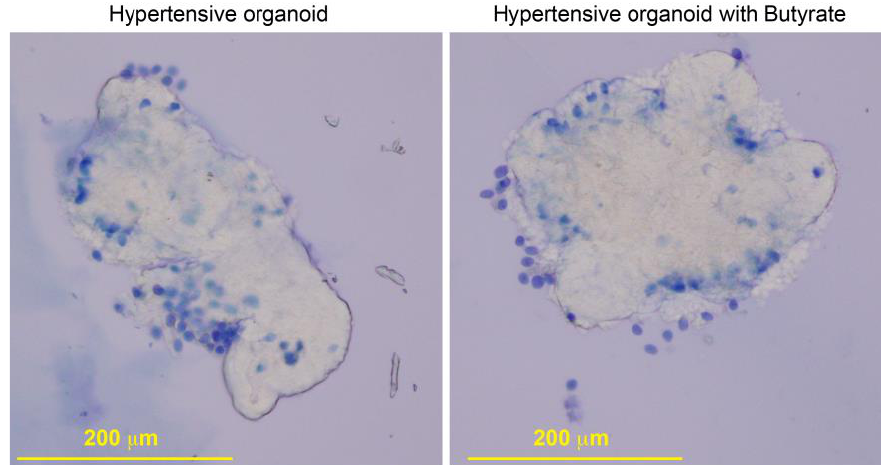
Figure 5. Phase microscopic images documenting growth of organoids from isolated colonic crypts of hypertensive subjects. Organoids were stained with trypan blue; dead cells are blue. Scale bar: 200 μm .